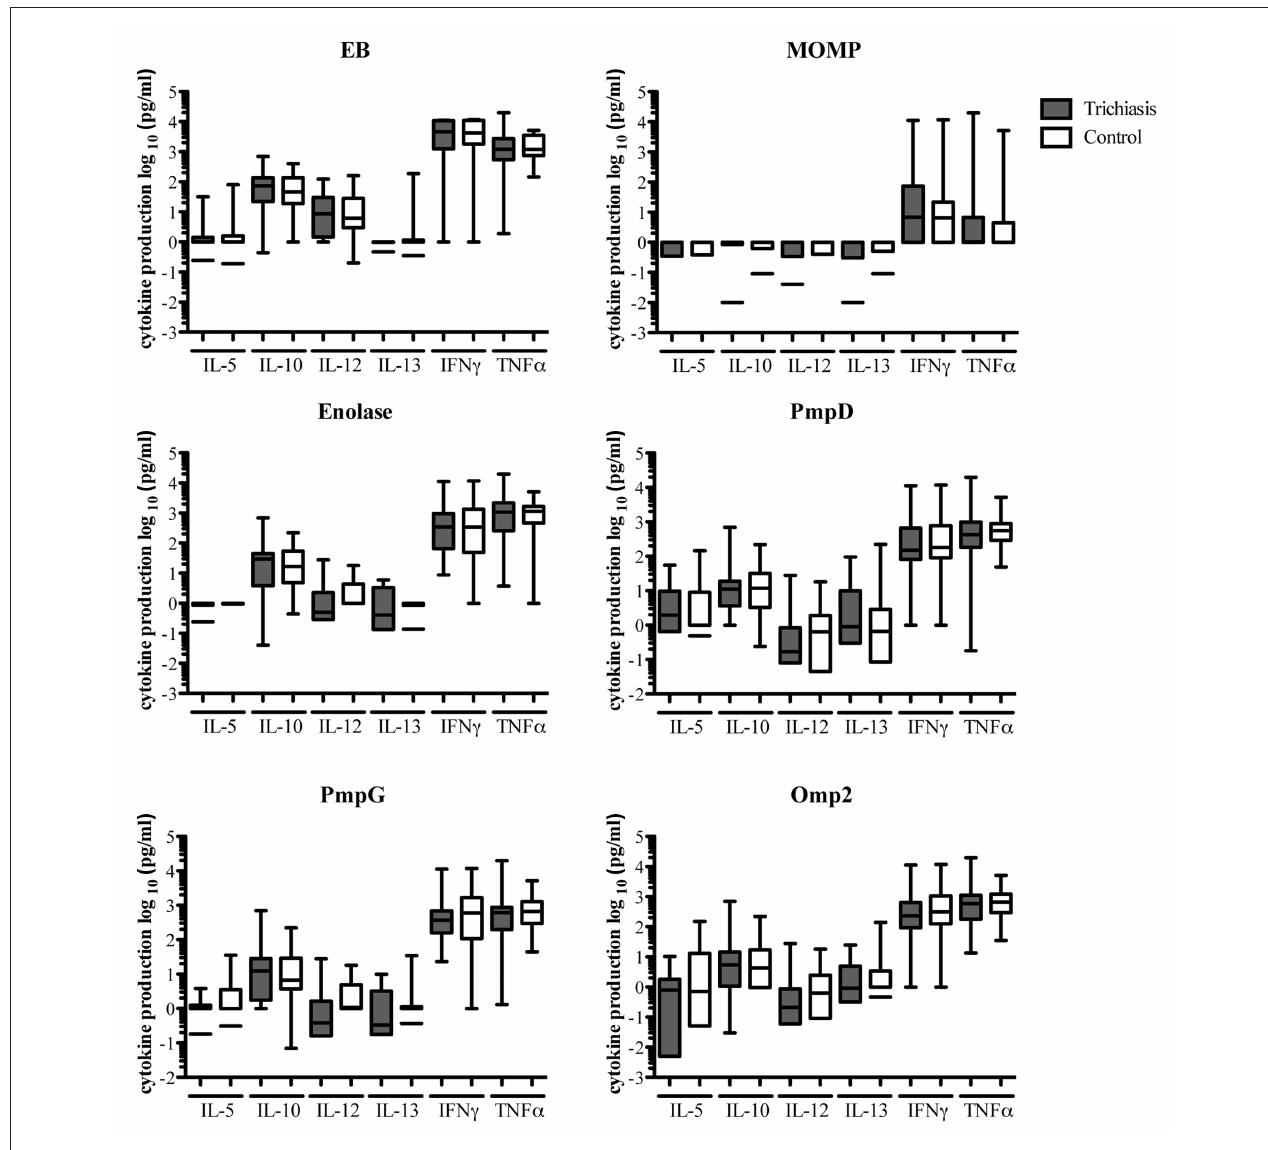
FiGure 2 | Chlamydial antigens induce cytokine responses that are significantly above responses of cultures in culture medium alone, however, the levels of cytokine production are not statistically different between diseased and non-diseased individuals. Each plot represents IL-5,